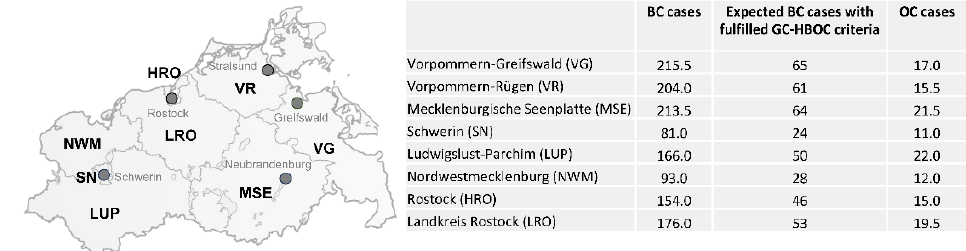
Figure 7. BC and OC cases in the districts of Mecklenburg-Western Pomerania. Shown are the average case numbers per year [10]. “Expected BC cases with fulfilled GC-HBOC criteria” are calculated assuming that 30% of them have a suspicious personal and/or family history [11]. Attribution for the map: [13].